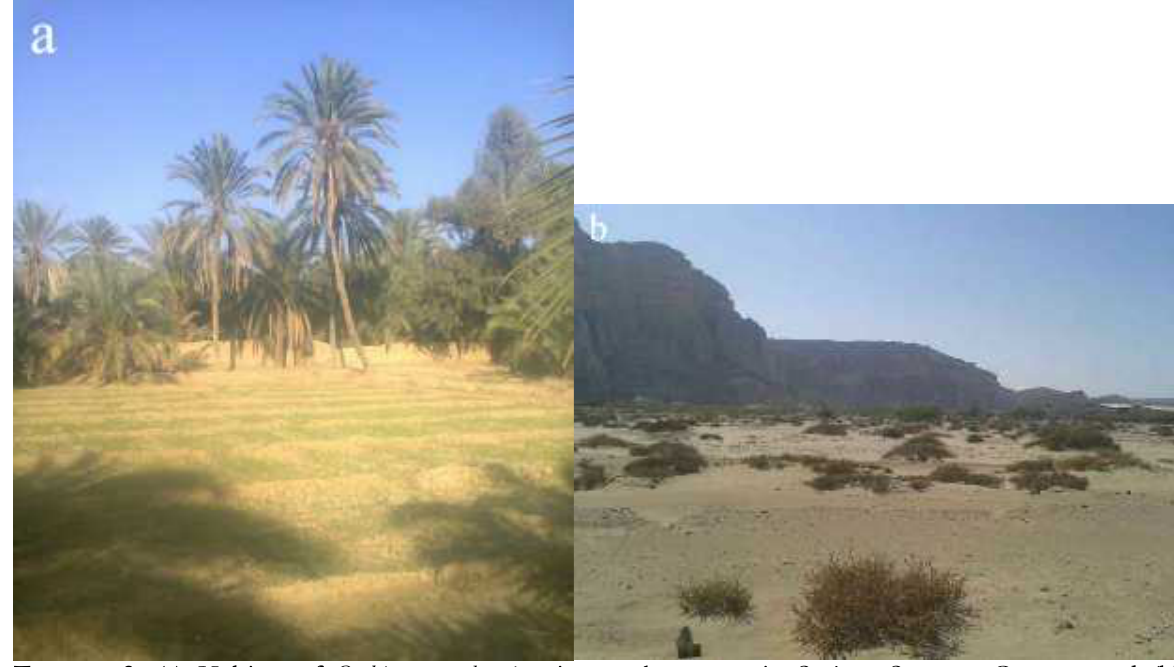
F IGURE 3. (a) Habitat of Ophiomorus brevipes in a palm grove in Sarjou, Saravan County, and (b) habitat of O. tridactylus in Beris-e Kohneh, Chabahar County, both in Sistan and Baluchestan Province. (Photo by Ehsan